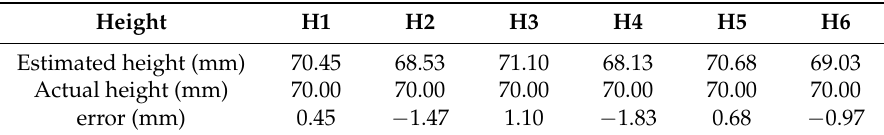
Table 3. Estimated height vs. actual height.